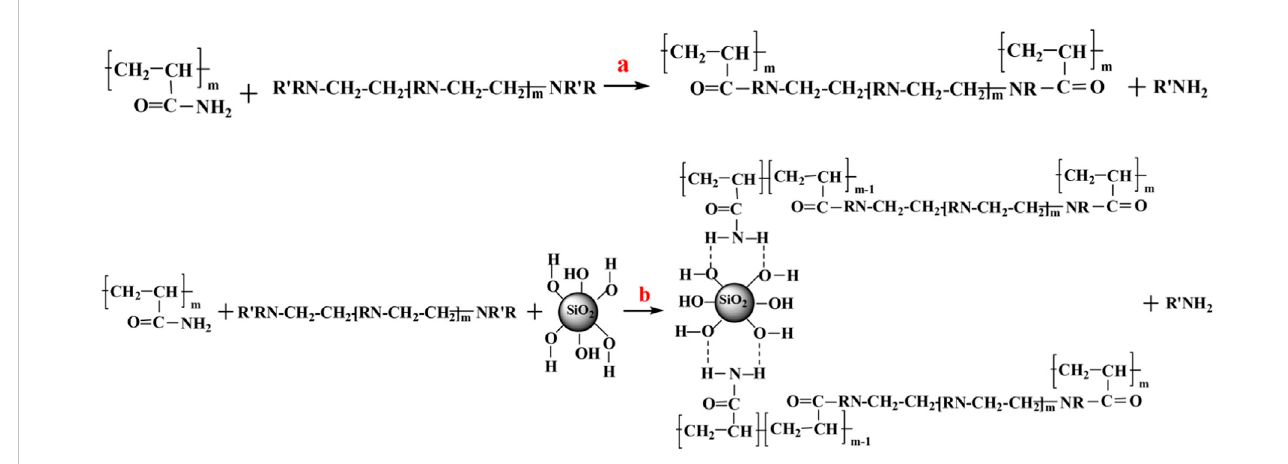
FIGURE 4 Schematic diagram of the enhanced gel system synthesis (Cassagnau,